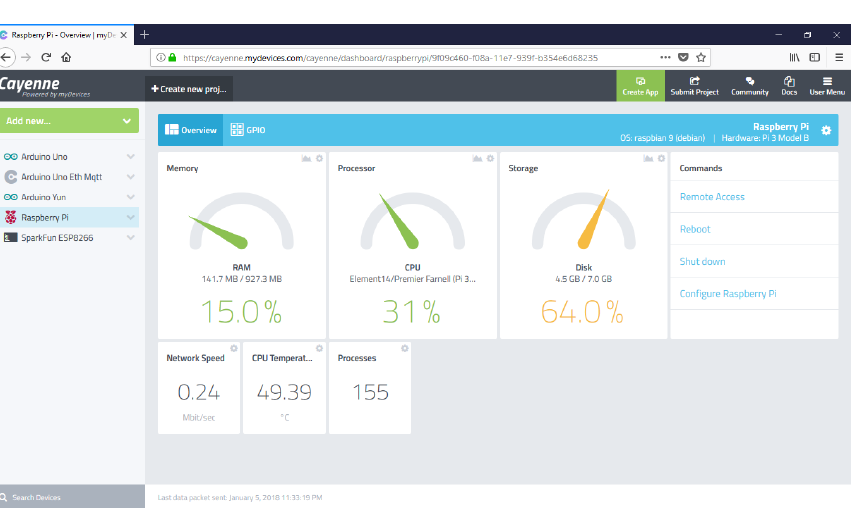
Fig. 1. Cayenne web page with devices and dashboard for Raspberry Pi